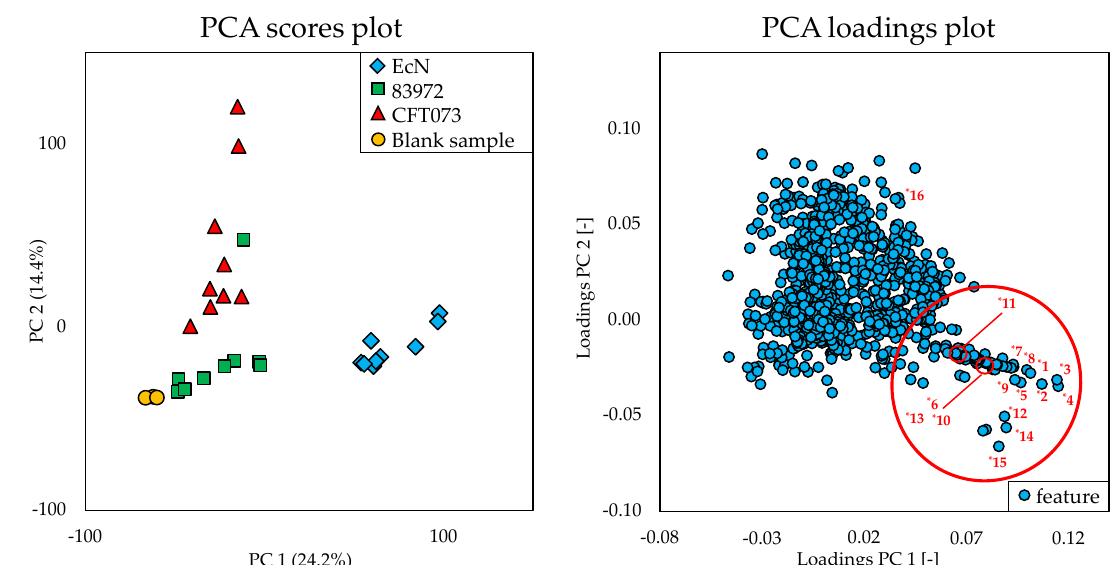
Figure 2. The principal component analysis (PCA) scores plot and the corresponding PCA loadings plot of the multivariate statistical analysis of the metabolome of the Escherichia coli ( E. coli ) strains EcN, 83972, and CFT073 cultivated in minimum essential medium (MEM) for 6 h and the blank sample treated under the same conditions. Three biological replicates of each strain were analyzed in triplicate. The labeled numbers of the red marked area correspond to the features of Table 1.